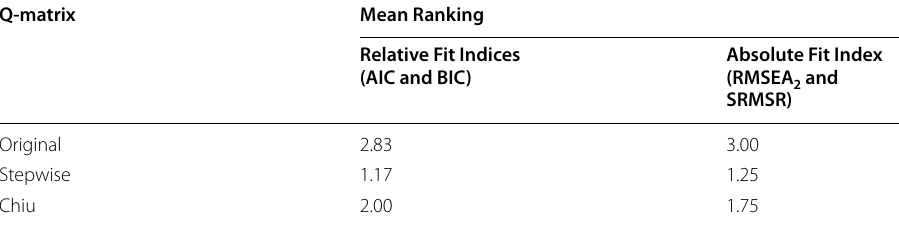
AIC Akaike Information Criterion, BIC Bayesian Information Criterion, RMSEA 2 the limited‑information version of Root Mean Square Error of Approximation, SRMSR Standardized Root Mean Square